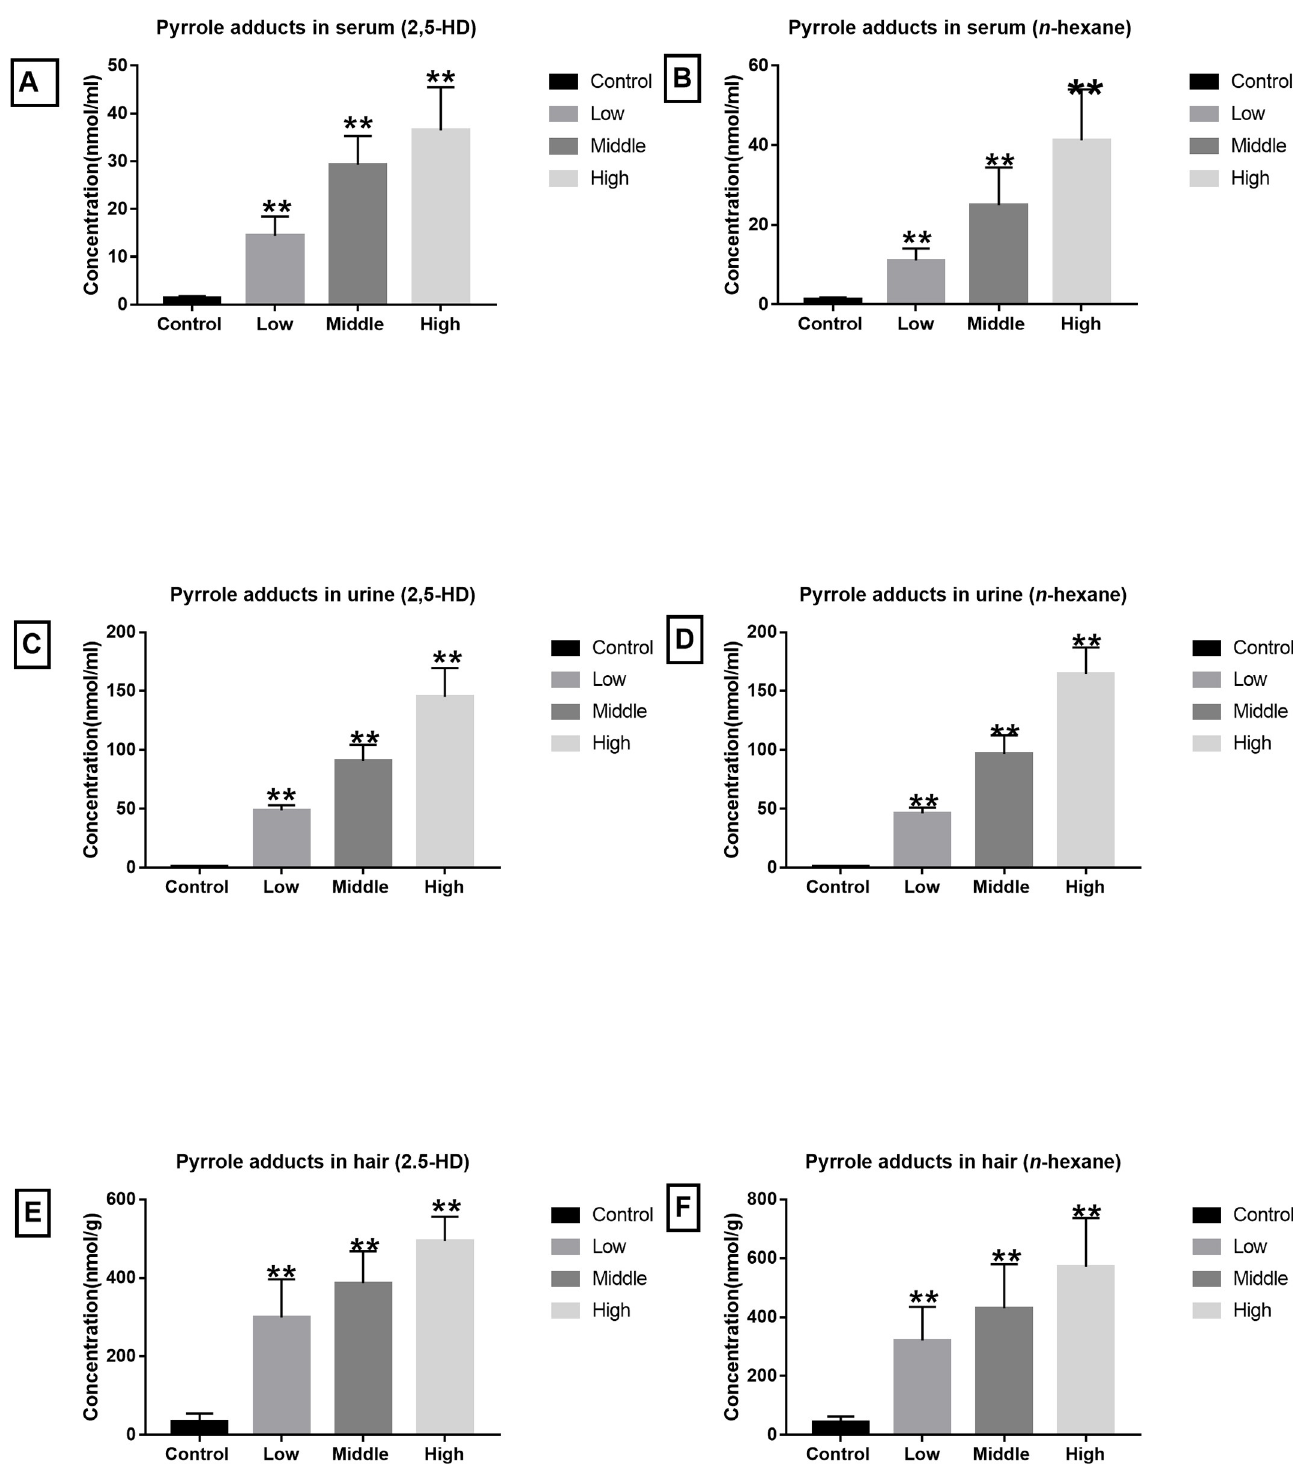
Fig 2. Pyrrole adducts accumulation. (A) Pyrrole adducts in serum of rats treated with 2,5-HD. (B) Pyrrole adducts in serum of rats treated with n -hexane. (C) Pyrrole adducts in urine of rats treated with 2,5-HD. (D) Pyrrole adducts in urine of rats treated with n -hexane. (E) Pyrrole adducts in hair of rats treated with 2,5-HD. (F) Pyrrole adducts in hair of rats treated with n -hexane. Compared with control group, �� P < 0.01.